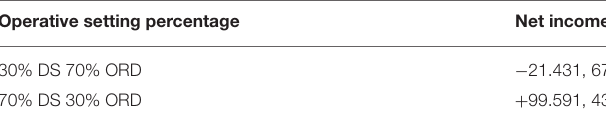
TABLE 4 | One-year income forecast. Operative setting